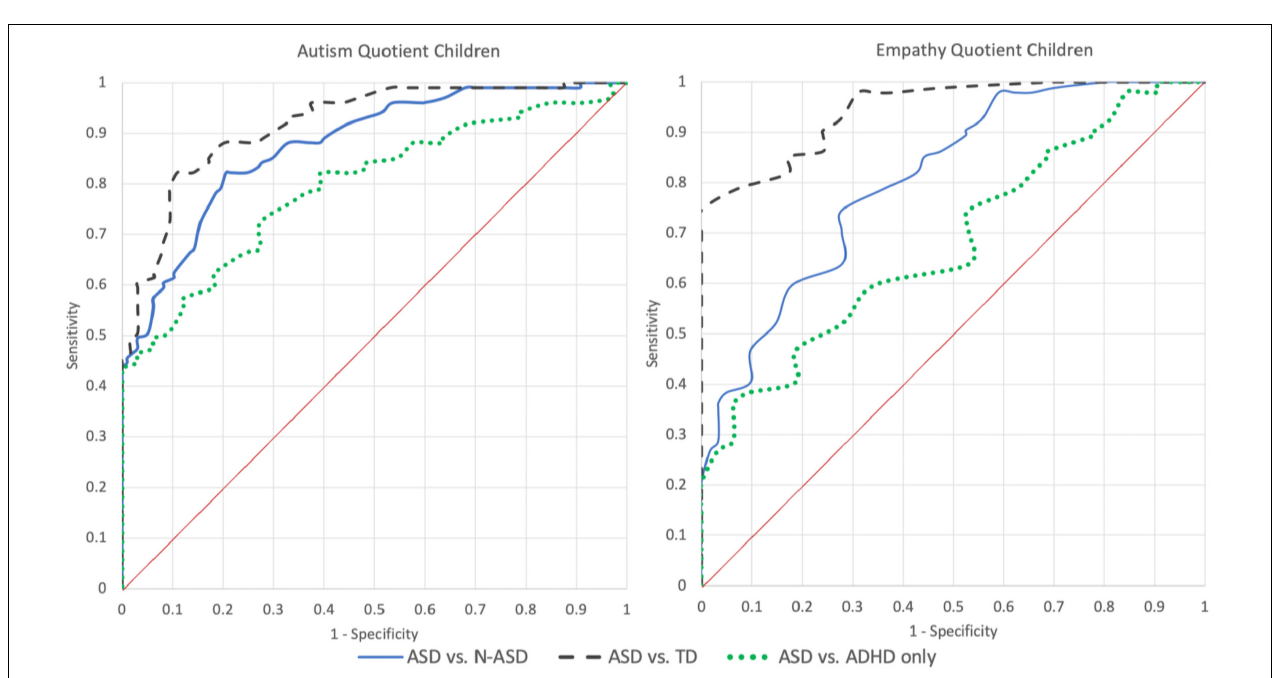
FIGURE 3 | ROC curves of the C-AQ and C-EQ for different combinations of groups. TD, Typical Development Group; ADHD, Attention Deficit and Hyperactivity Group; ASD, Autism Spectrum Disorder with or without comorbid ADHD Group; N-ASD, TD and ADHD grouped together.